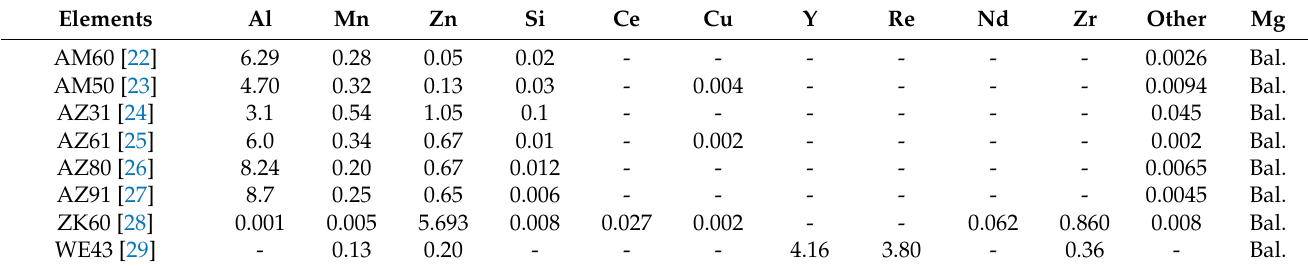
Table 1. Composition of main Mg alloys (weight percent).